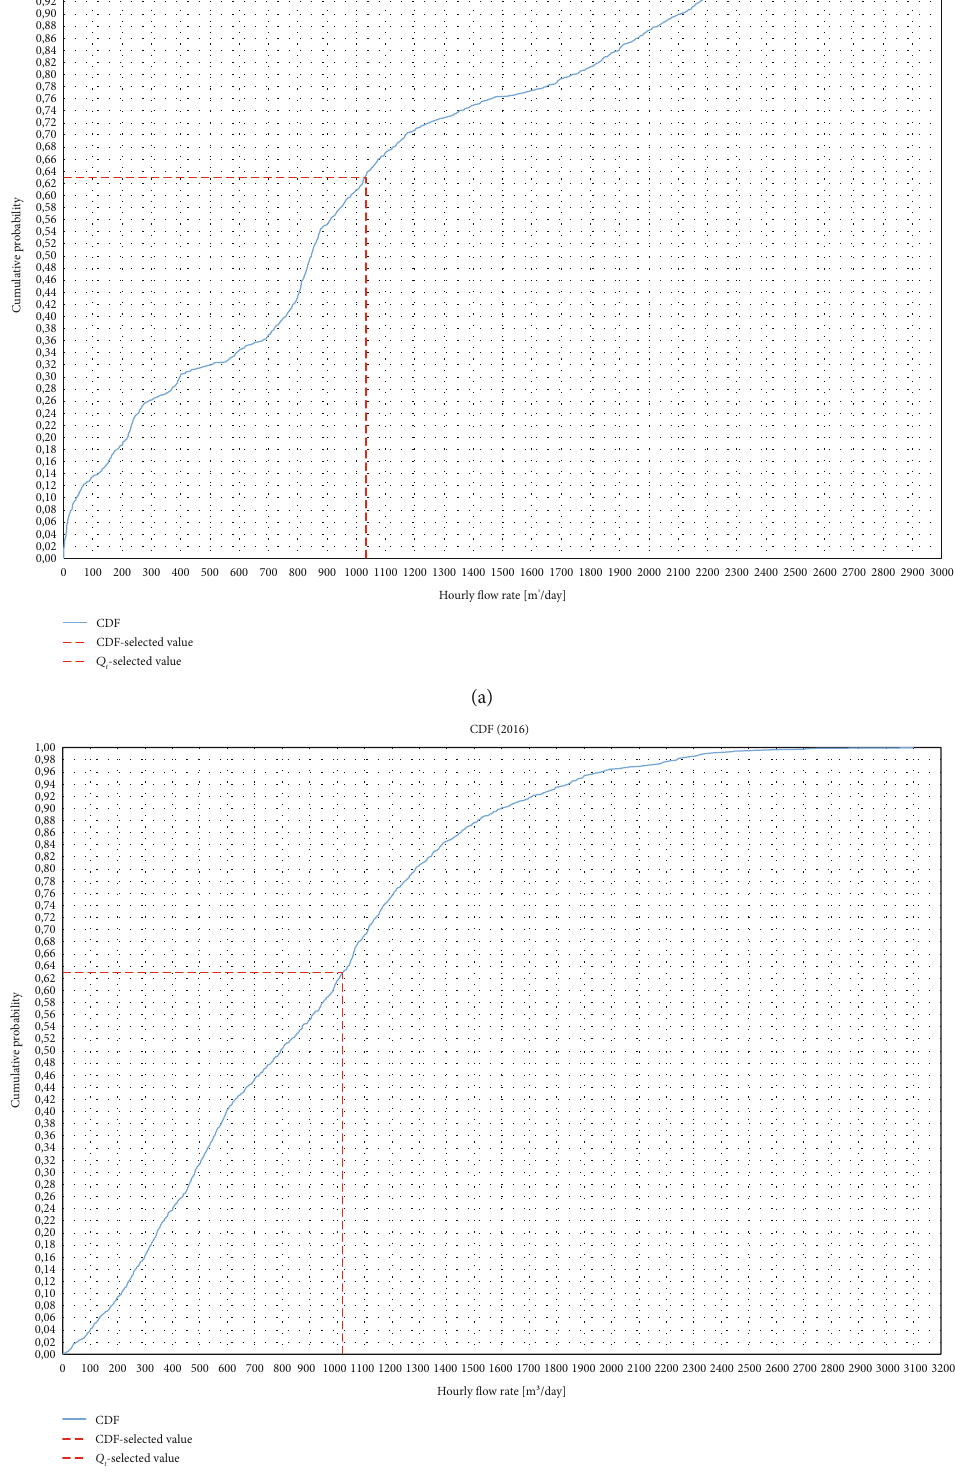
fi xing CDF-selected value equal to 63%. (a) Functioning season 2010; (b) Functioning Figure 10: Relative value of Q t , evaluated by season